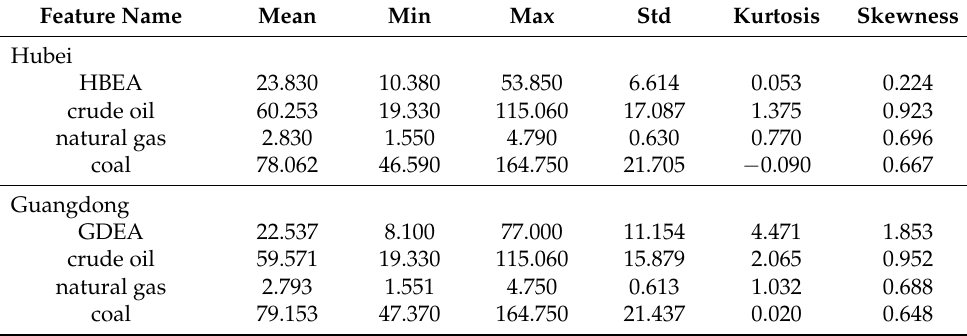
Table 3. Two time-series data sets